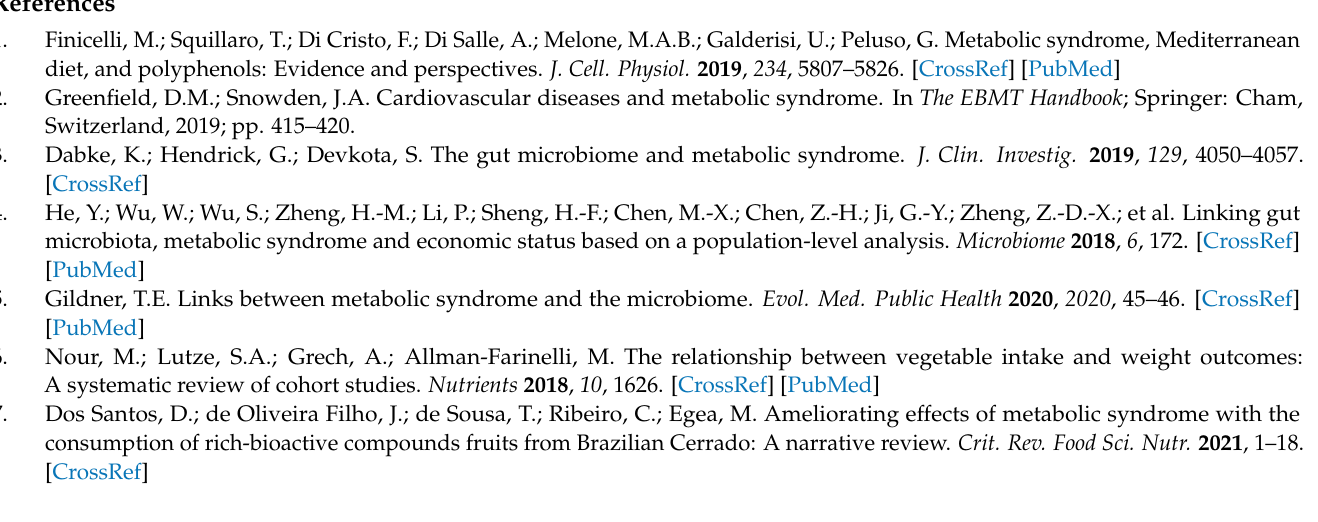
Table S1: Compositions of Experimental Diets and Serving Information, and Table S2: Most signif- icantly regulated hepatic mRNAs and associated ligand activated transcription factors from male C57BL/6J mice fed high fat (HF) plus cashew pseudofruit (HF+CP) vs. HF diet for 10